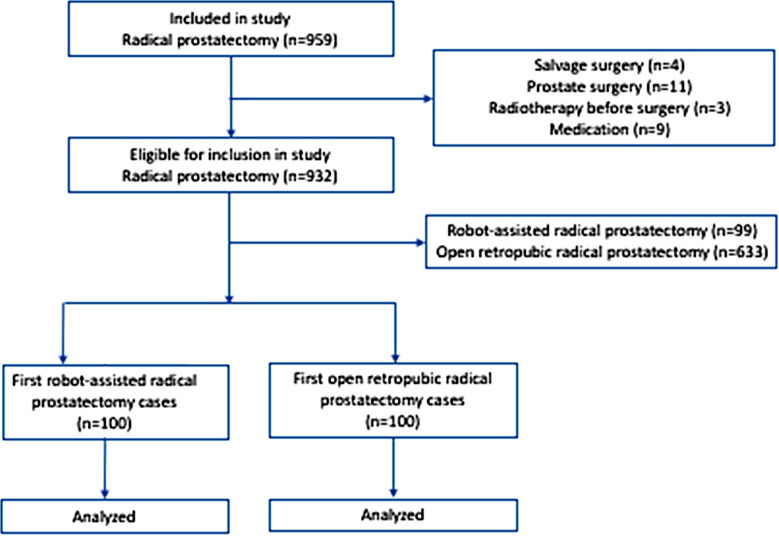
Flowchart for the study population.